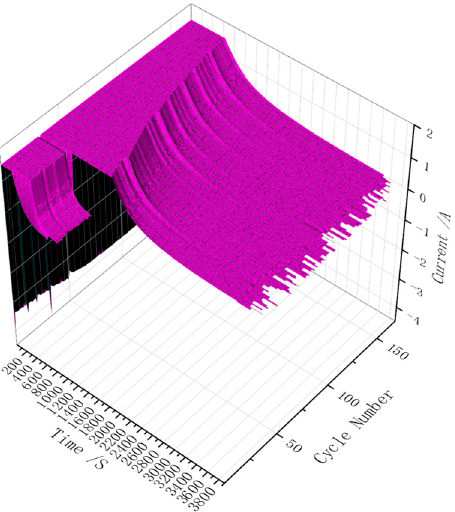
Figure 4. Charging current curve of different cycles.